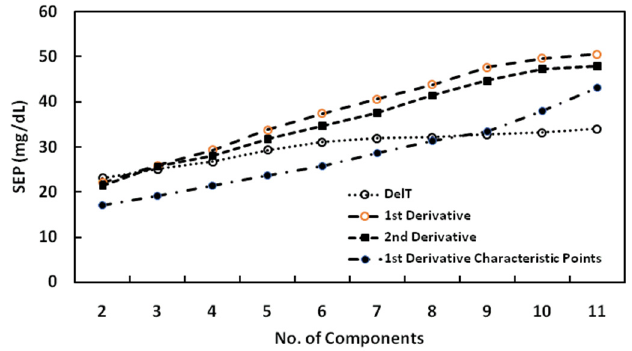
Figure 10. SEP against a different number of principal components (PCs) achieved for Partial Least Square Regression (PLS) model built with different preprocessing approaches. Table 3. Comparison of performances of different PLS models.